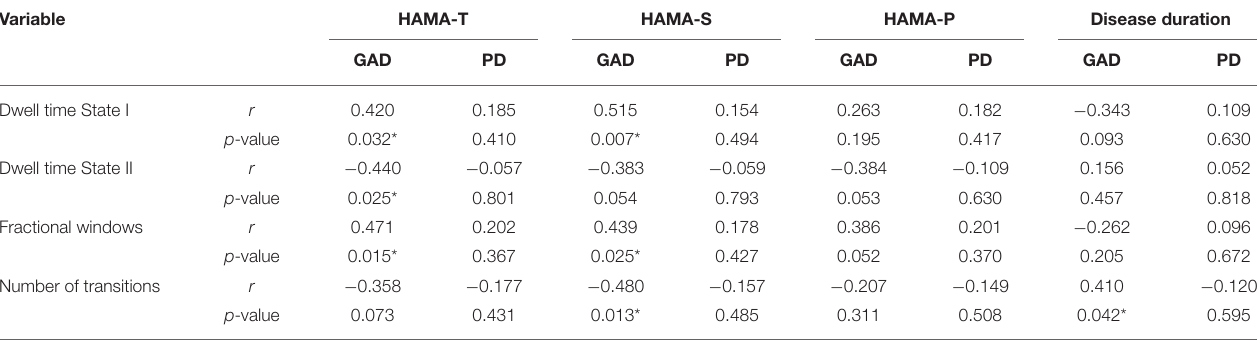
TABLE 2 | The correlations between the temporal properties of dynamic functional connectivity and the clinical characteristics.